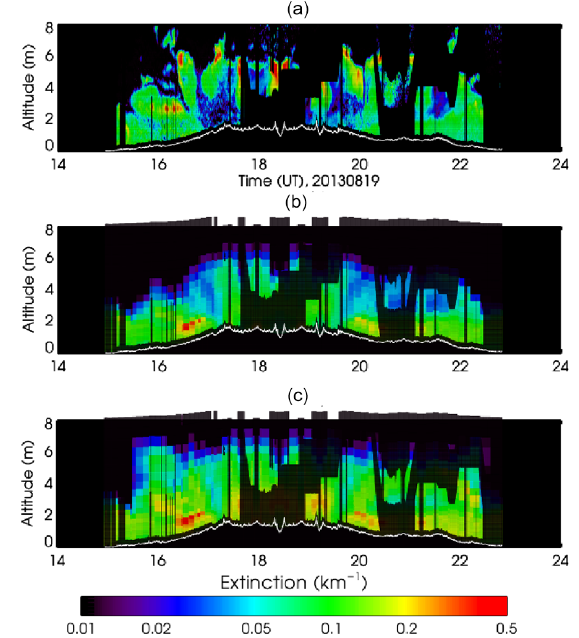
Figure 13. Cross sections of the aerosol extinction at 532nm; (a) observed along the tracks of the research flights of SEAC4RS of 19 August 2013; (b) C-IFS forecast with biomass burning aerosols emitted at surface and (c) at the PRM mean height of maximum injection provided by